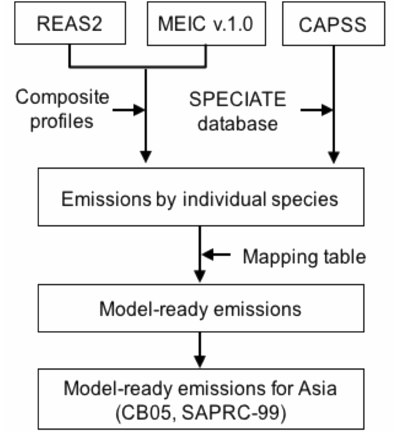
Figure 3. NMVOC speciation scheme used in the MIX inventory development. The mapping table is derived from Carter